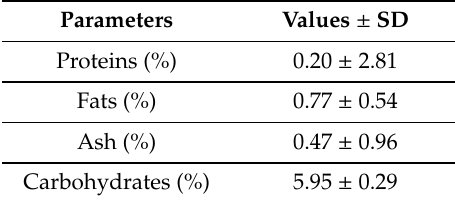
Table 2. Bromatological analysis of corncob hydrolysate.